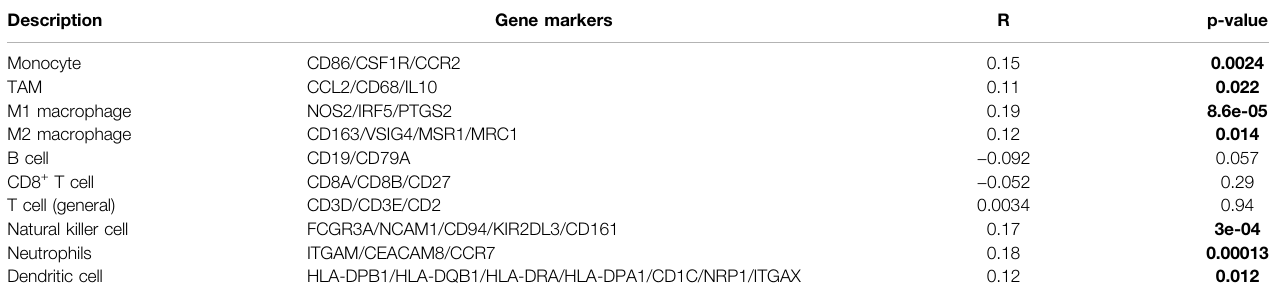
TABLE 3 | Spearman association between CMTM6 and typical markers of major immune cells in GEPIA2. On the X-axis is CMTM6, and on the Y-axis are cell markers. The bold stands for statistical difference.